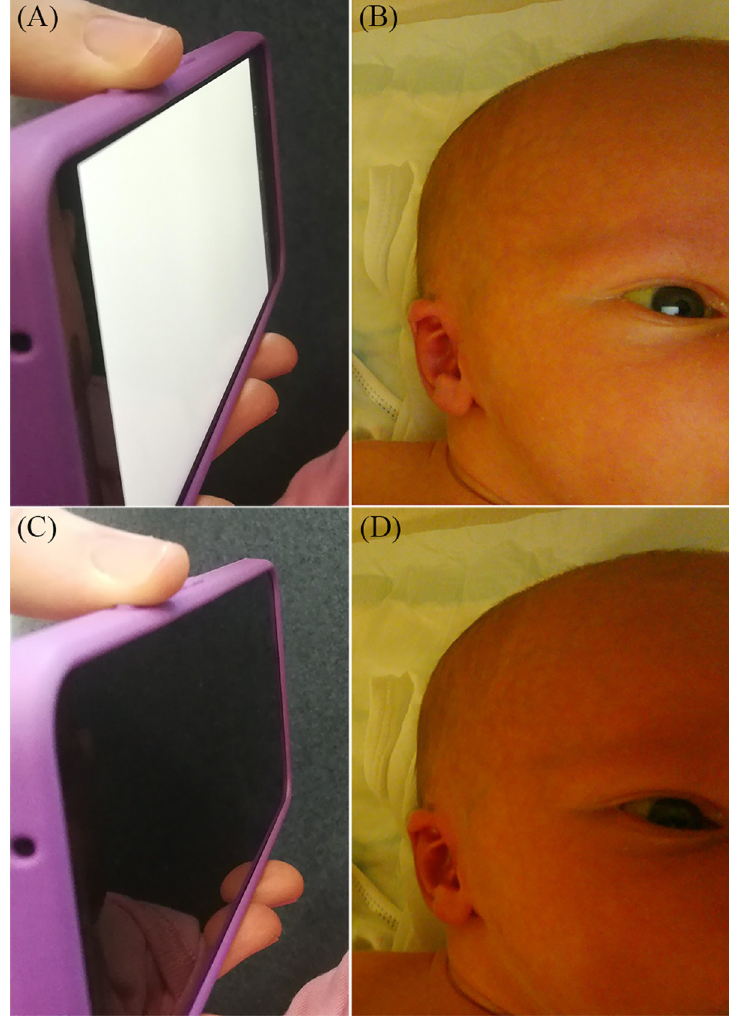
Fig 1. neoSCB app screen illumination sequence and typical flash/ no-flash sclera image pair. (A) Screen illumination on for flash image capture. (B) Example of flash image captured by app. (C) Screen illumination off for no-flash image capture. (D) Corresponding no-flash image captured by app. Media consent was provided by the parents. brightness. For the second, the screen is off. These will be referred to as the flash and no-flash images, respectively. The screen is white by default, turning off only briefly to take the second, no-flash image. This means the eye can adapt to the brightness, avoiding exposure to an over- stimulating flash. The image capture is triggered using the smartphone volume keys. Fig 1 shows the neoSCB app in use, with screen illumination on and off, alongside a typical flash/ no-flash image pair captured by the app.